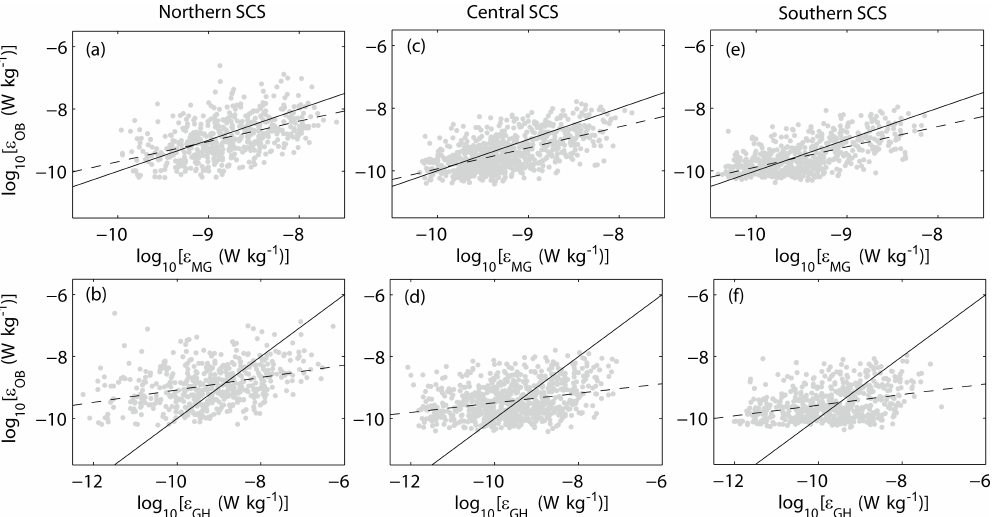
Figure 10. Observed dissipation ( ε OB ) plotted against modeled (top) MG and (bottom) GH dissipation for the northern SCS (a–b) , central SCS (c–d) , and southern SCS (e–f) . The solid lines indicate the one-to-one relation: log 10 (ε OB ) = log 10 (ε GH ) or log 10 (ε OB ) = log 10 (ε MG ) . The dash lines indicate the linear fittings of the